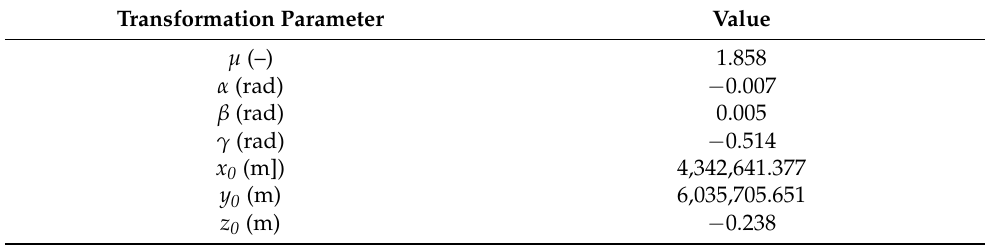
Table 10. Seven-parameter Transformation (Bursa-Wolf